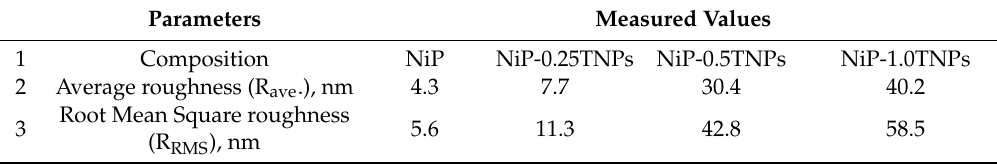
Table 3. Elemental compositions of the different obtained coatings.